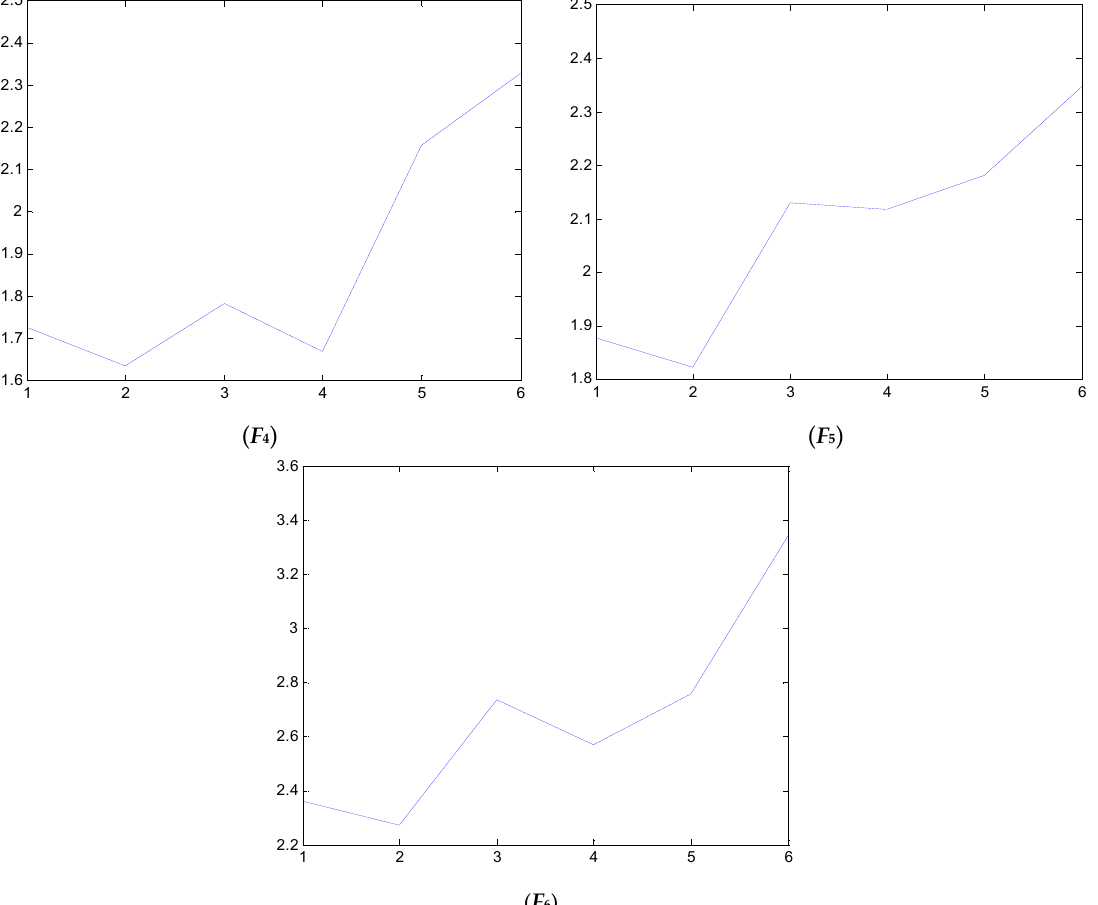
Figure 15. The analyzed results of A fan No. 2H sensor by F 4 , F 5 and F 6 .